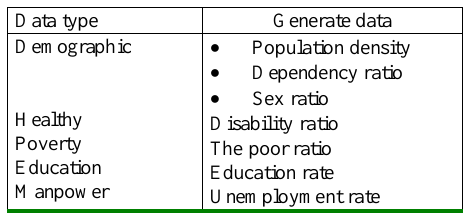
Table 1. The kinds of data used in determining social vulnerability